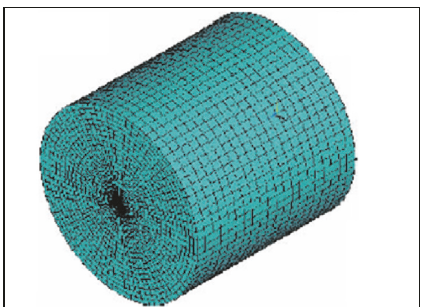
Figure 4: Sweep meshing of wellbore.